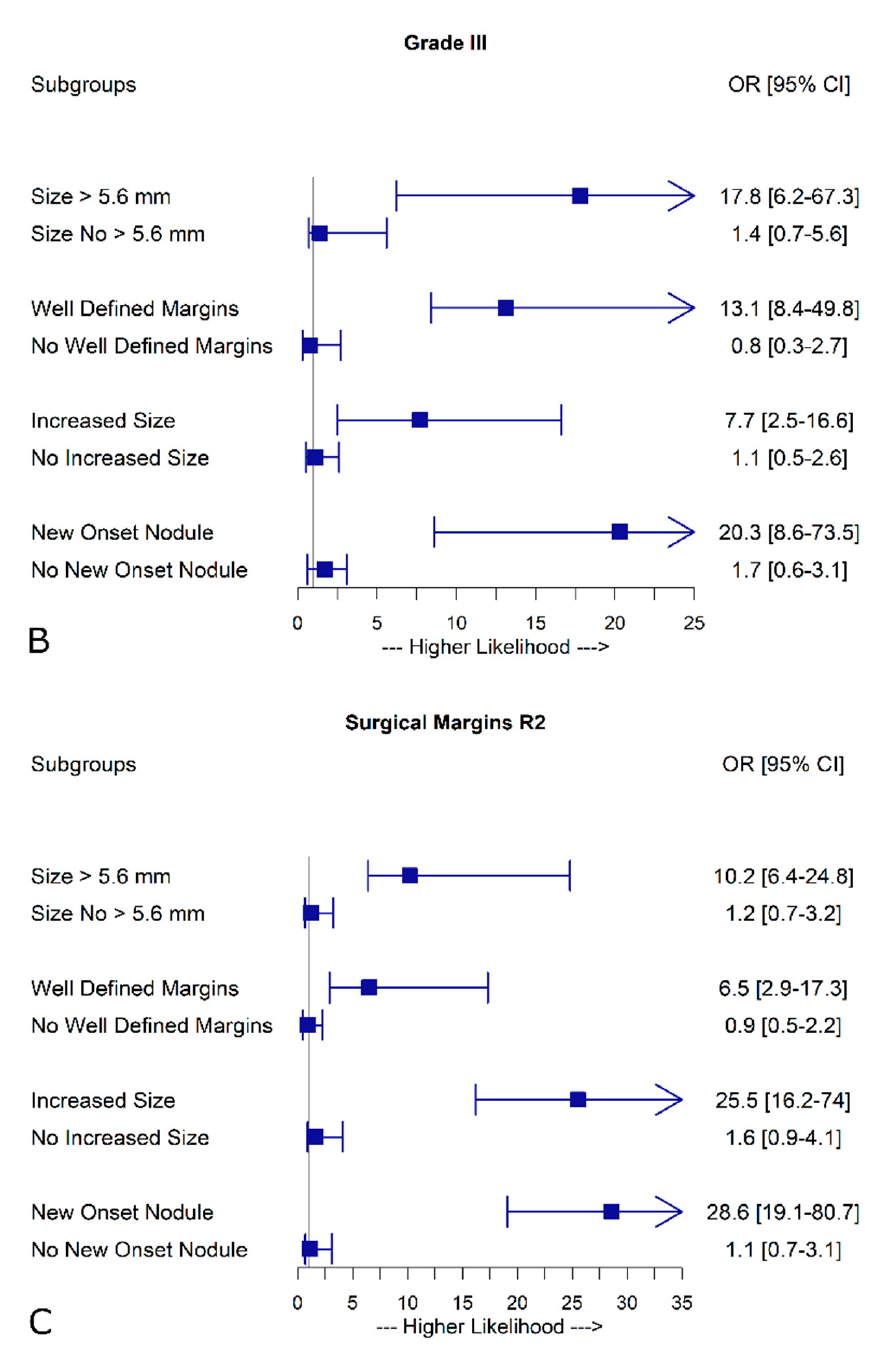
Figure 4. Interactions between multiple metastases and potential influencing factors. ( A ) Interaction between leiomyosarcoma and significant CT features. ( B ) Interaction between primary tumor grade III and significant CT features ( C ) Interaction between R2 surgical resection margins and significant CT